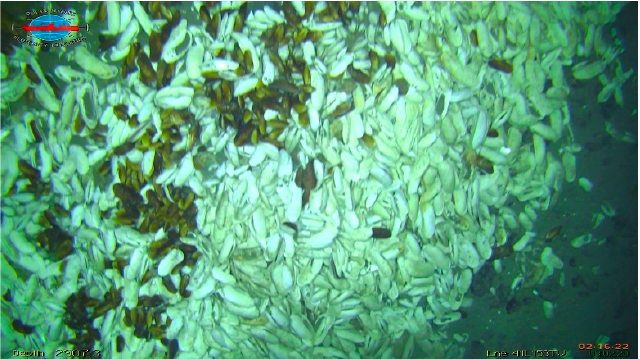
Figure 10. Massive accumulation of bivalves near the Koralovoye HF.